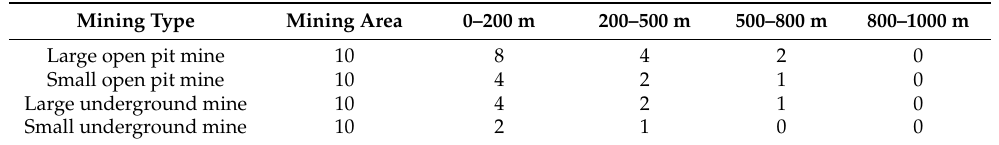
Table 3. Parameter table of influence degree and scope of mining type determined from relevant studies [30,46], and expert judgment based on onsite